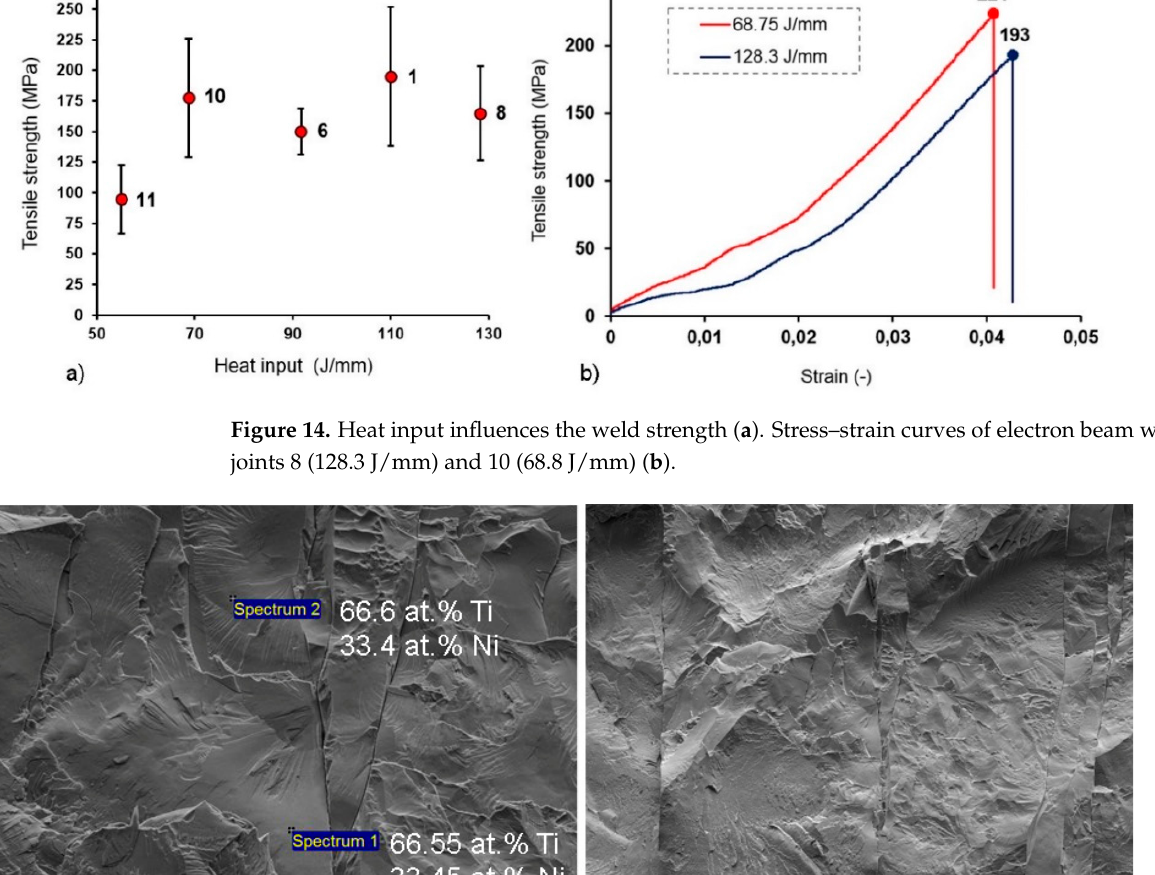
Figure 14. Heat input influences the weld strength ( a ). Stress–strain curves of electron beam welded joints 8 (128.3 J/mm) and 10 (68.8 J/mm) ( b ).